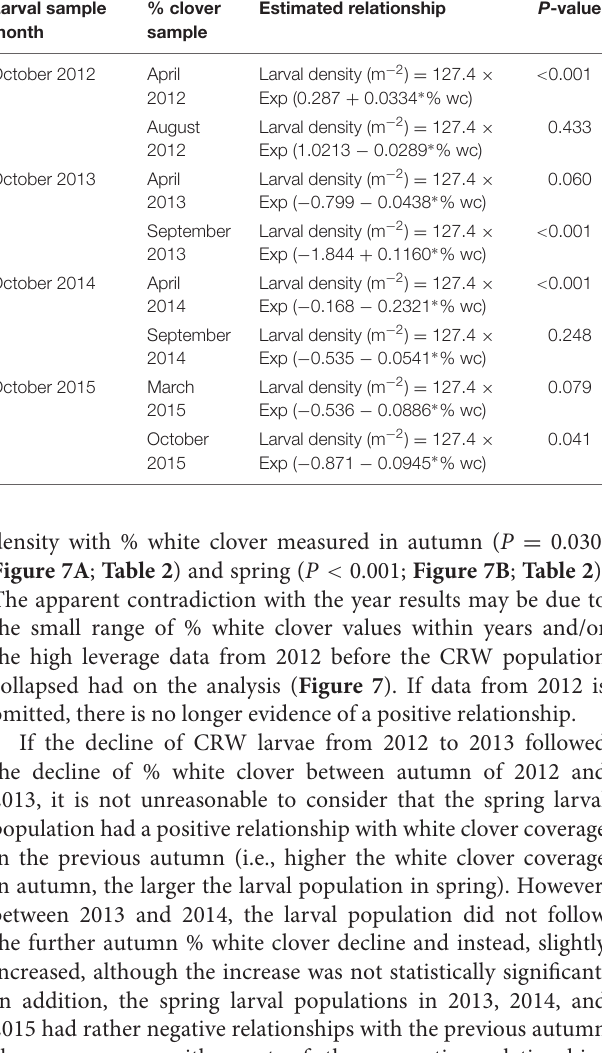
TABLE 1 | Equations describing the relationship between CRW larval density and % white clover (% wc) measured from 2012 to 2015. Larval sample % clover month sample